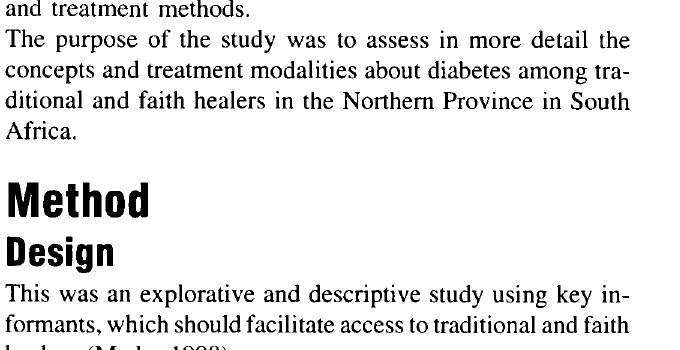
Table 1 : Clinical manifestations of diabetes by traditional healer (TH) and faith healer (FH) by